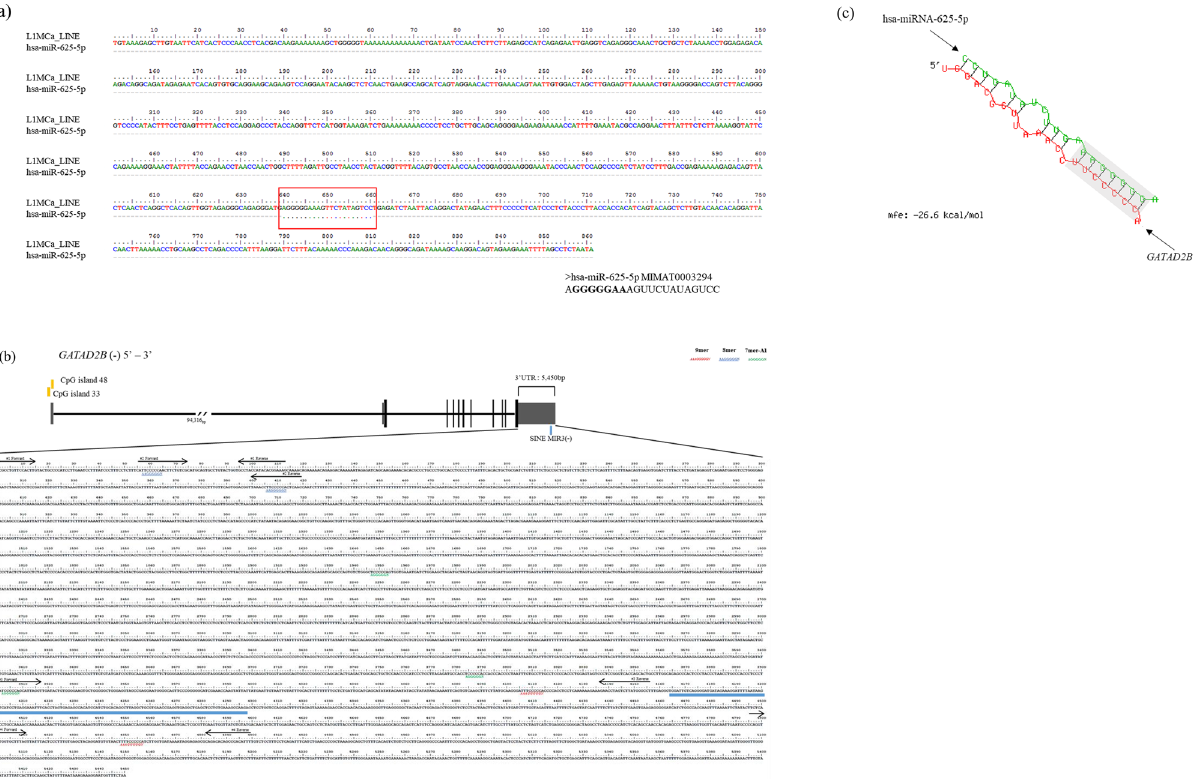
Figure 1. ( a ) The alignment result of LINE-L1MCa and hsa-miRNA-625-5p. The red box shows the conserved region of hsa-miRNA-625-5p and LINE-L1MCa. The hsa-miRNA-625-5p sequence is shown under the alignment, and the seed region is in bold. ( b ) Schematic structure of GATAD2B and the alignment result. The CDS regions are in black, and UTRs are grey. Two CpG islands are located in the 5 ′ UTR of GATAD2B . In the 3 ′ UTR of GATAD2B , there were seven binding sites of hsa-miRNA-625-5p. Additionally, one of the transposable elements, SINE MIR3, is located in the 3 ′ UTR of GATAD2B . In the 3 ′ UTR of GATAD2B sequences, 9mer hsa- miRNA-625-5p is indicated as italicized AAA GGG GGN in red, 8mer is indicated as underlined AAG GGG GN in blue, and 7mer-A1 is indicated as AGG GGG N in green. Additionally, four primers designed in the 3 ′ UTR of GATAD2B are indicated in black arrows with each number and directions. ( c ) Bioinformatic analysis of hsa- miRNA-625-5p and GATAD2B . RNA hybrid of hsa-miRNA-625-5p and 3 ′ UTR of GATAD2B . The seed region of hsa-miRNA-625-5p and complementary binding site of GATAD2B 3 ′ UTR are in the grey box. The mfe value between hsa-miRNA-625-5p and GATAD2B 3 ′ UTR is -26.6 kcal/mol.